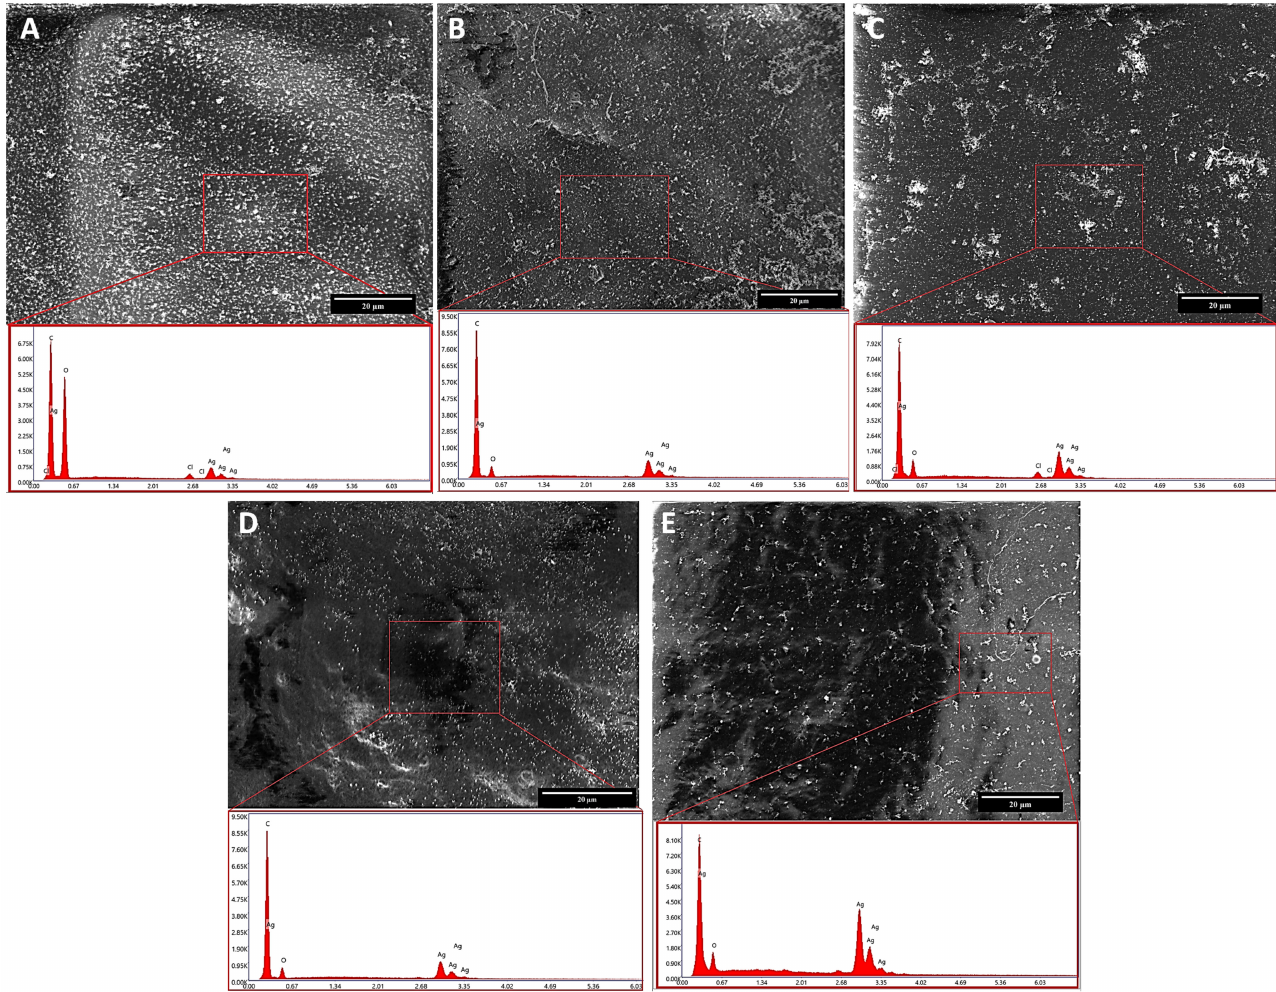
Figure 3. SEM micrographs and corresponding EDS analysis of ( A ) F 5 , ( B ) F 10 , ( C ) F 20 , ( D ) F 30 and ( E ) F 40 film, respectively. The scale bar is 20 µ